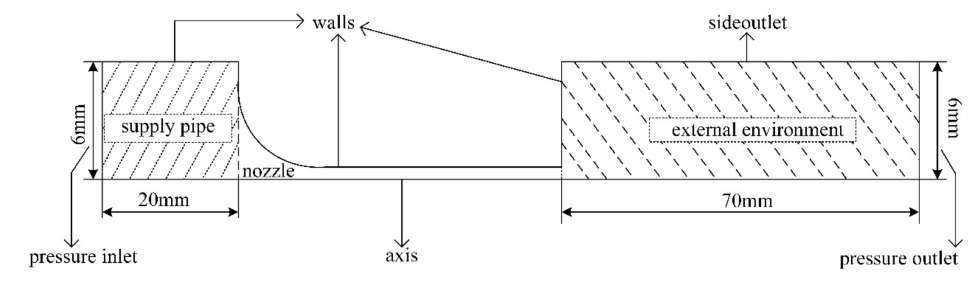
Figure 3. Simulation model.